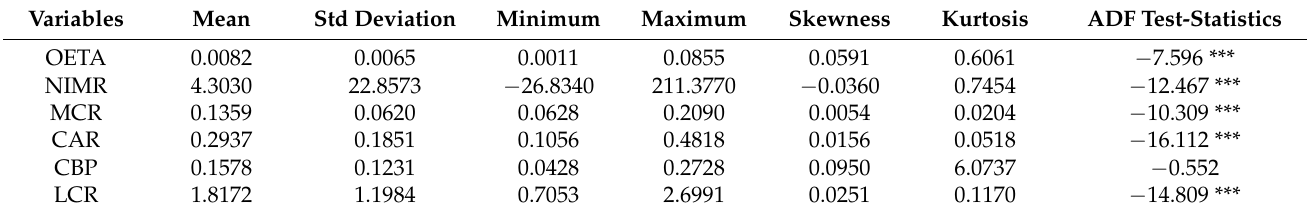
Table 2. Summary statistics, normality and stationarity test results of the